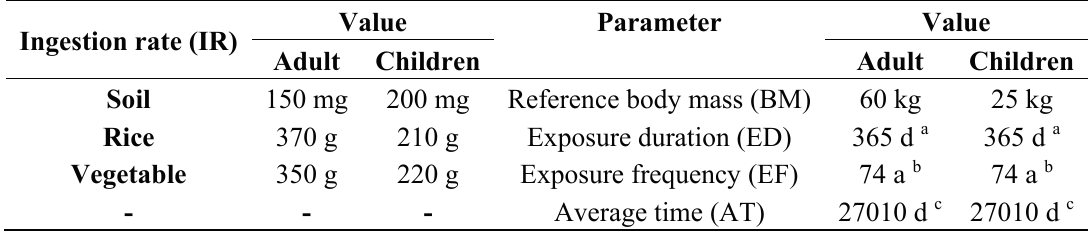
Table 1. Parameters used in risk assessment.